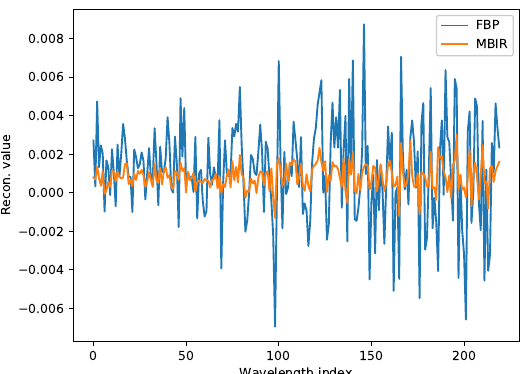
Figure 7. Line profile through the center of the rock. Notice that the FBP produces a very noisy reconstruction as a function of wavelength